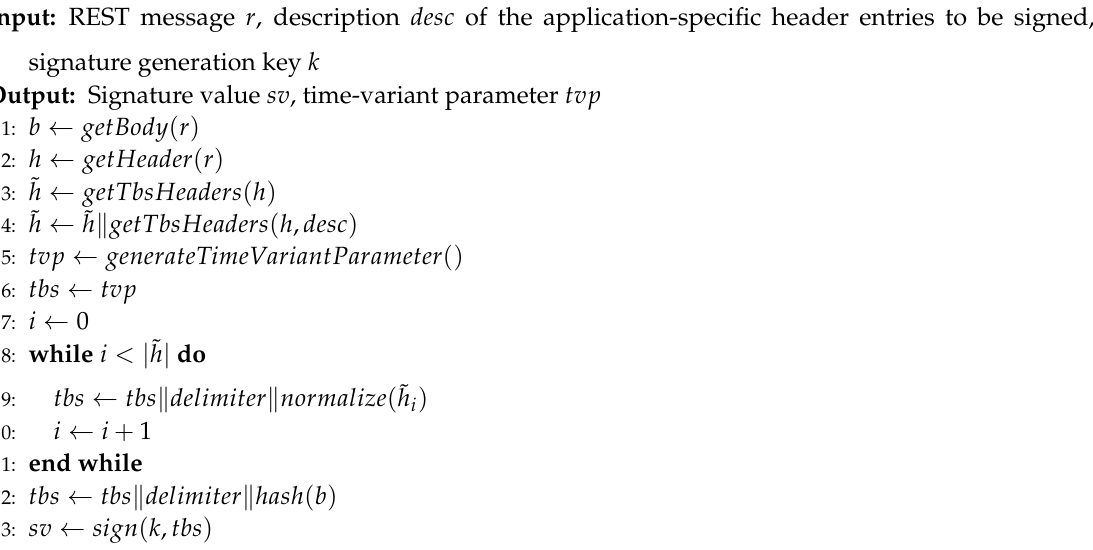
Algorithm 1 Representational state transfer (REST) message signature generation